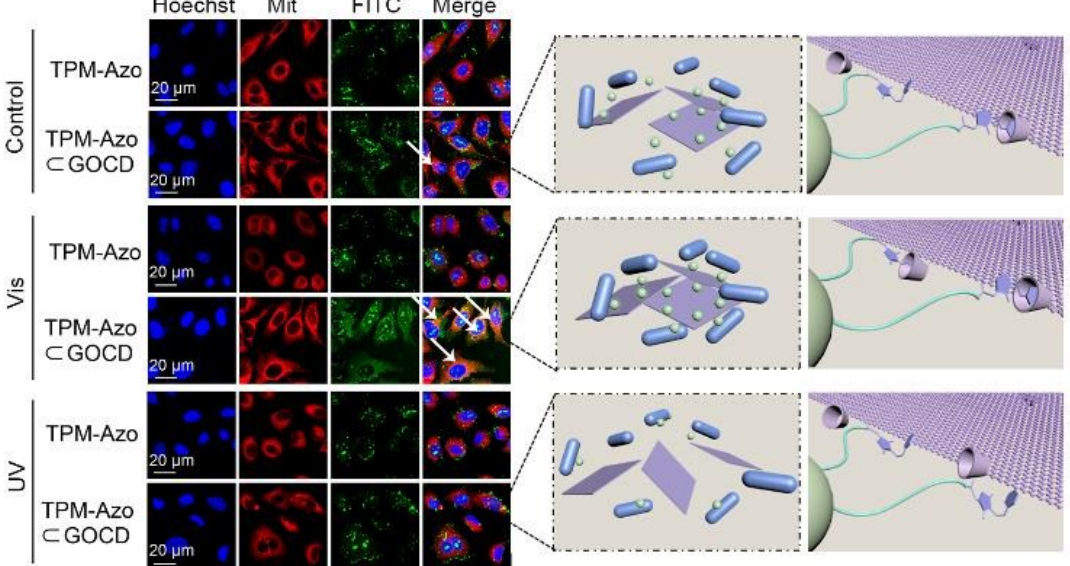
Figure 2. Light-controlled intracellular mitochondrial disruption by azobenzene and mitochondrion-targeting peptide-modified transferrin and CD-modified GO. Mitochondrial disruption (white arrows) after visible-light irradiation (Vis, 520 nm) but not after UV irradiation (UV, 365 nm). The effect of azobenzene and mitochondrion-targeting peptide-modified transferrin and CD-modified GO on intracellular mitochondrial dynamics was investigated by confocal microscopy. (Adapted with permission from Ref. [28]. Copyright 2019, Royal Soc. Chemistry).